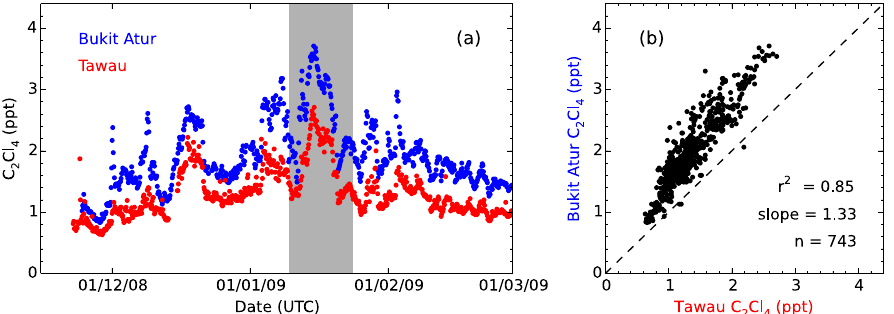
Figure 1. (a) shows a time series of 3h mean C 2 Cl 4 measurements collected at Bukit Atur (blue) and Tawau (red) during the winter of 2008/2009. The period analysed in more detail in Section 4 is shaded grey. (b) shows the correlation between the measurements at the two sites. The coefficient of determination ( r 2 ), the gradient of the regression line (slope) and the number of 3h periods for which data exist at both measurement locations (n) are noted. In constructing this figure, two outlying 3h mean measurements from Tawau ( > 6ppt) have been discounted. Both high mixing ratios are likely to be due to a very local C 2 Cl 4